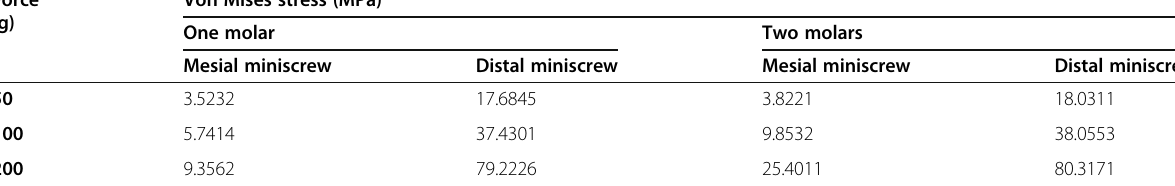
Table 3 Maximum von Mises stress in the miniscrews (MPa)